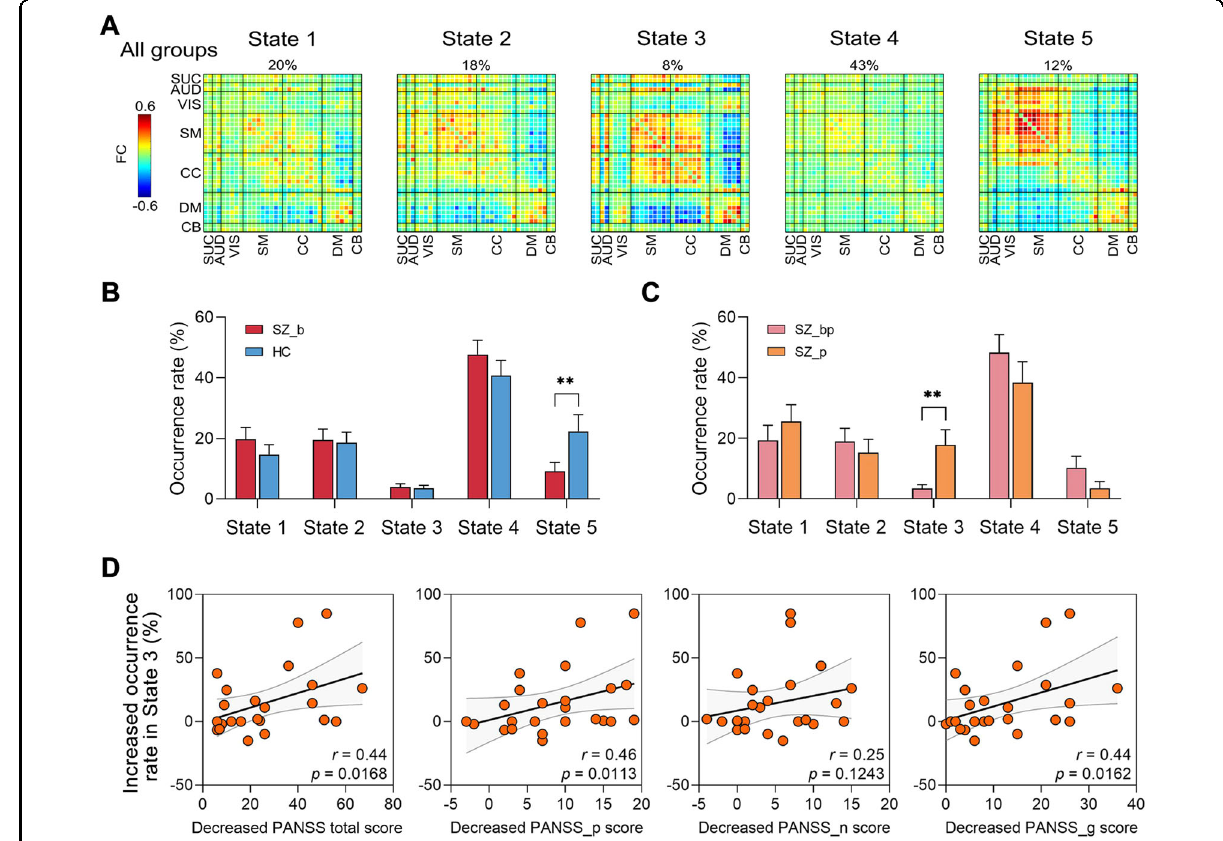
Fig. 1 Dynamic functional connectivity patterns and association with psychosis symptoms. A Five discrete dynamic functional connectivity patterns across all groups. The percentage of occurrences is listed above each cluster centroid. The color bar represents z values of functional connectivity (FC). B Differences in state occurrences between baseline schizophrenia patient (SZ_b) and healthy control (HC) groups. C Group differences in state occurrences between post-treatment (SZ_p) and paired baseline patients (SZ_bp). D Associations between changed occurrences of the State 3 and improved psychosis symptoms after treatment. ** P < 0.01,